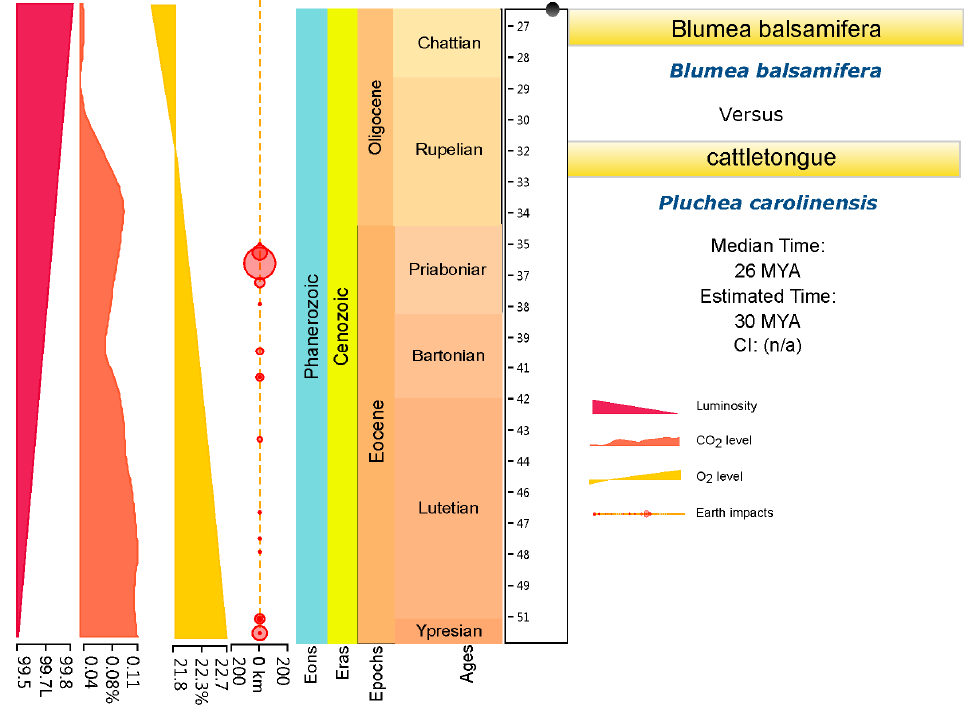
Figure 6. The divergence time estimation between Blumea balsamifera DC. and Pluchea. Carolinensis (Jacq.) G. Don., based on TimeTree.